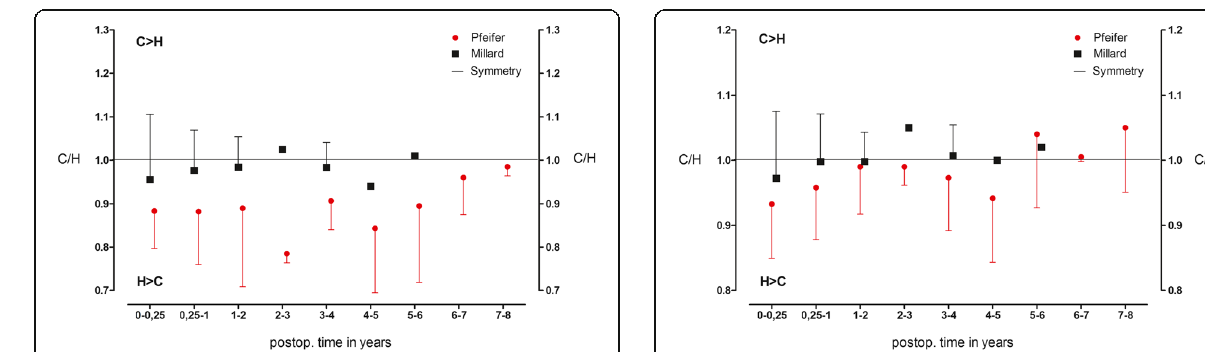
Fig. 3 Relation of Philtrum length. Symmetry quotient for the Philtrum length over the entire follow-up period in the Millard group ( n =36) compared to the Pfeifer group ( n =44) ( p <0.001). Presented as the means±standard deviation (SD)